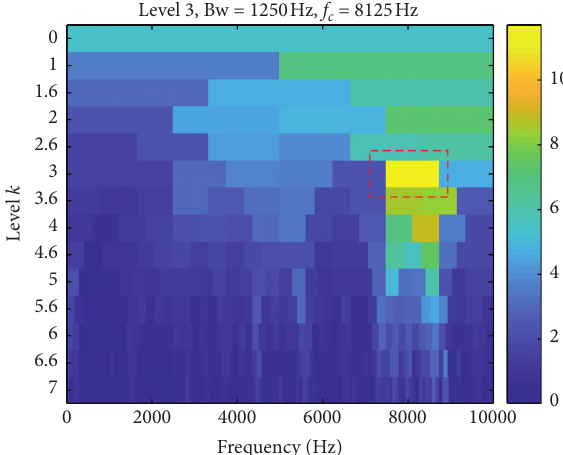
Figure 16: The colormap of data via fast kurtogram.